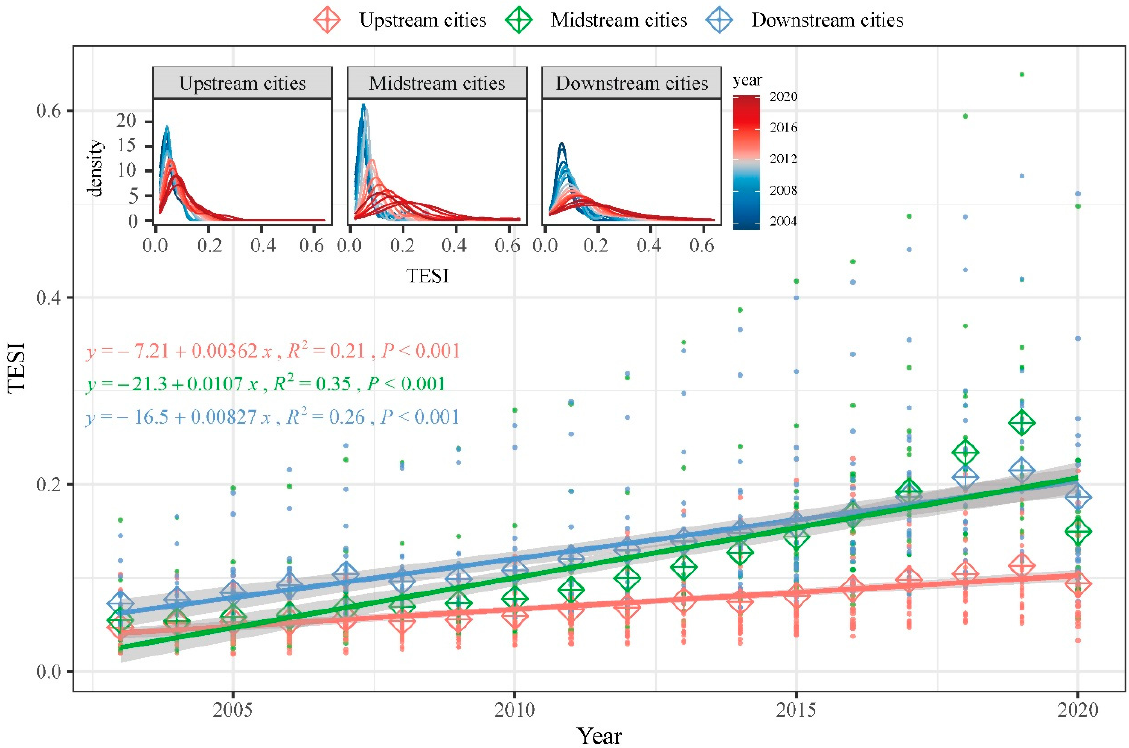
Figure 4. The kernel density and temporal evolution trend of the urban tourism eco-security index in the upper, middle, and lower reaches of the Yellow River